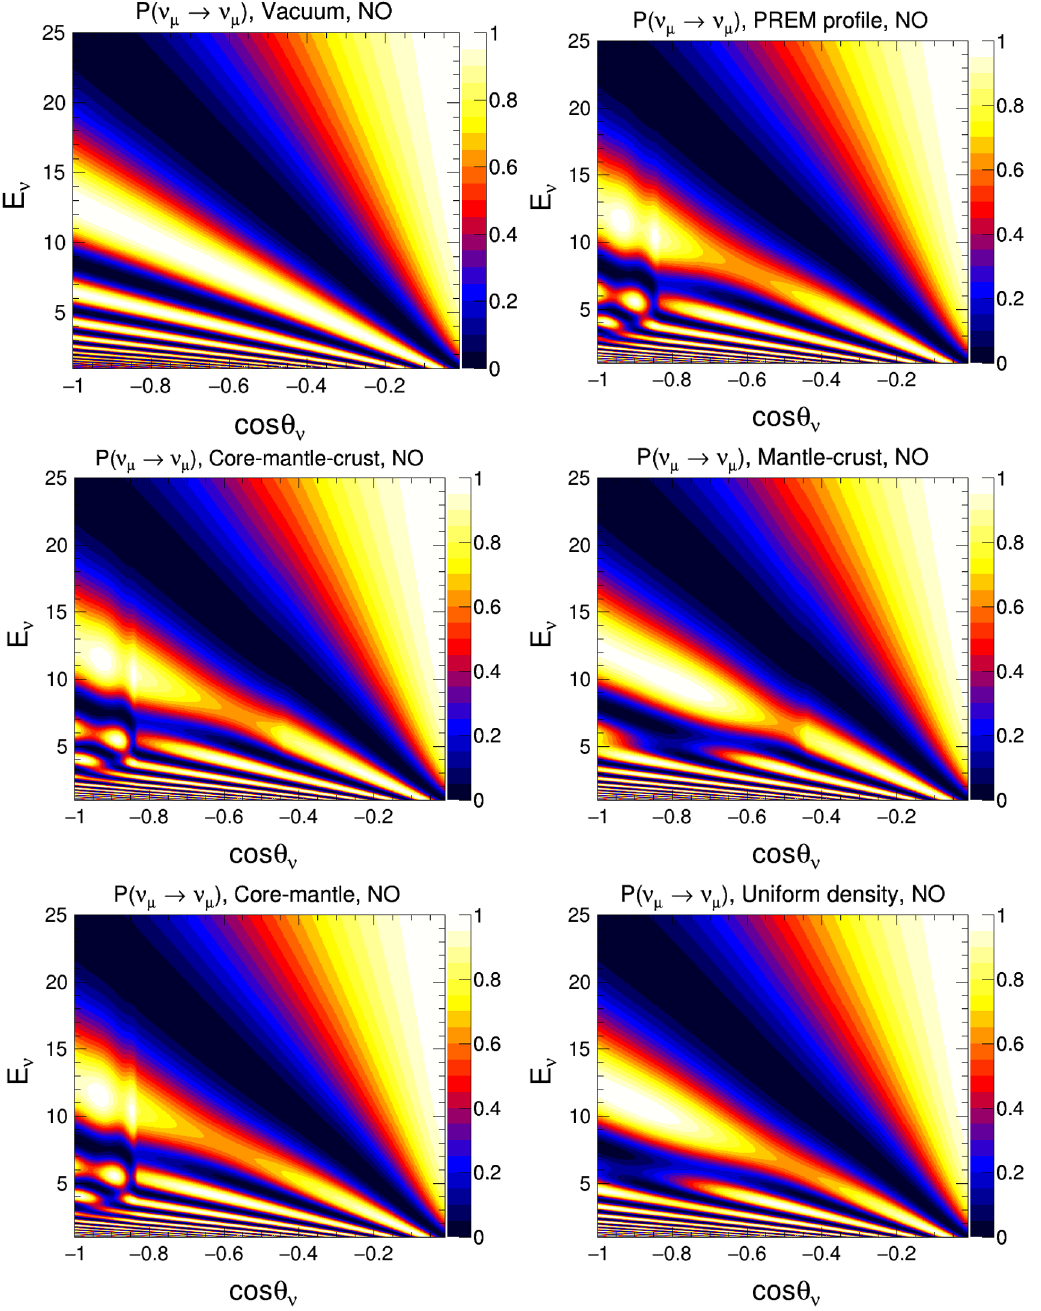
Figure 2 . P ( ν µ → ν µ ) oscillograms considering various density profiles of Earth. We take the three-flavor oscillation parameters from table 2. We assume NO and sin 2 θ